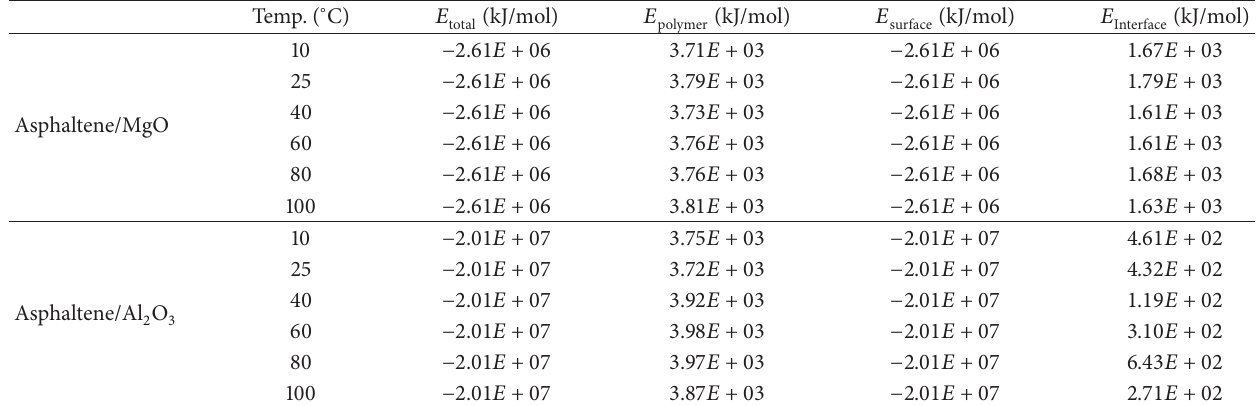
Figure 14: The interface configuration of asphaltene/Al 2 O 3 (10–40 ∘ C). Table 2: Asphaltene/MgO and asphaltene/Al 2 O 3